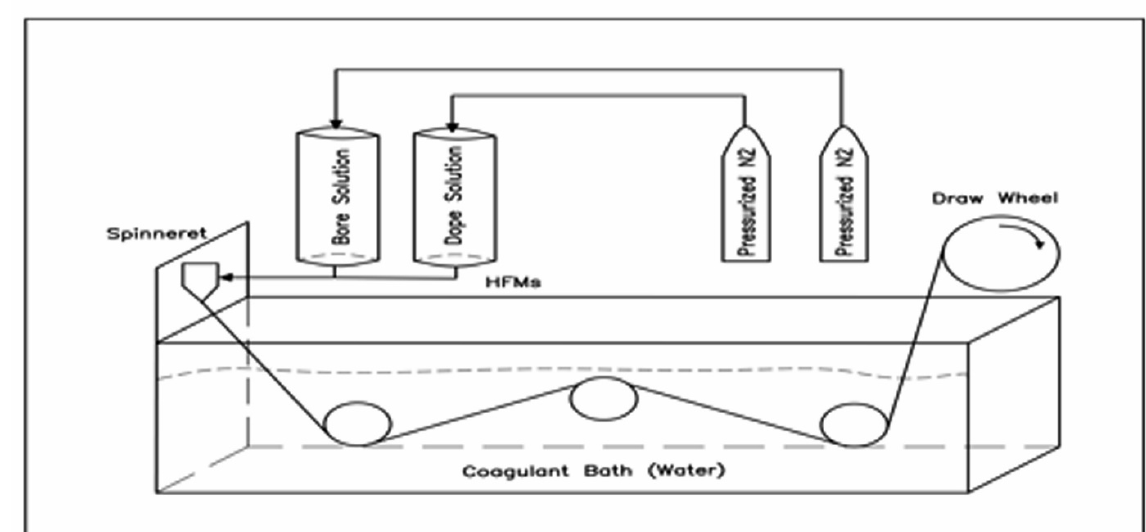
Figure 2. Conventional hollow fiber membrane spinning